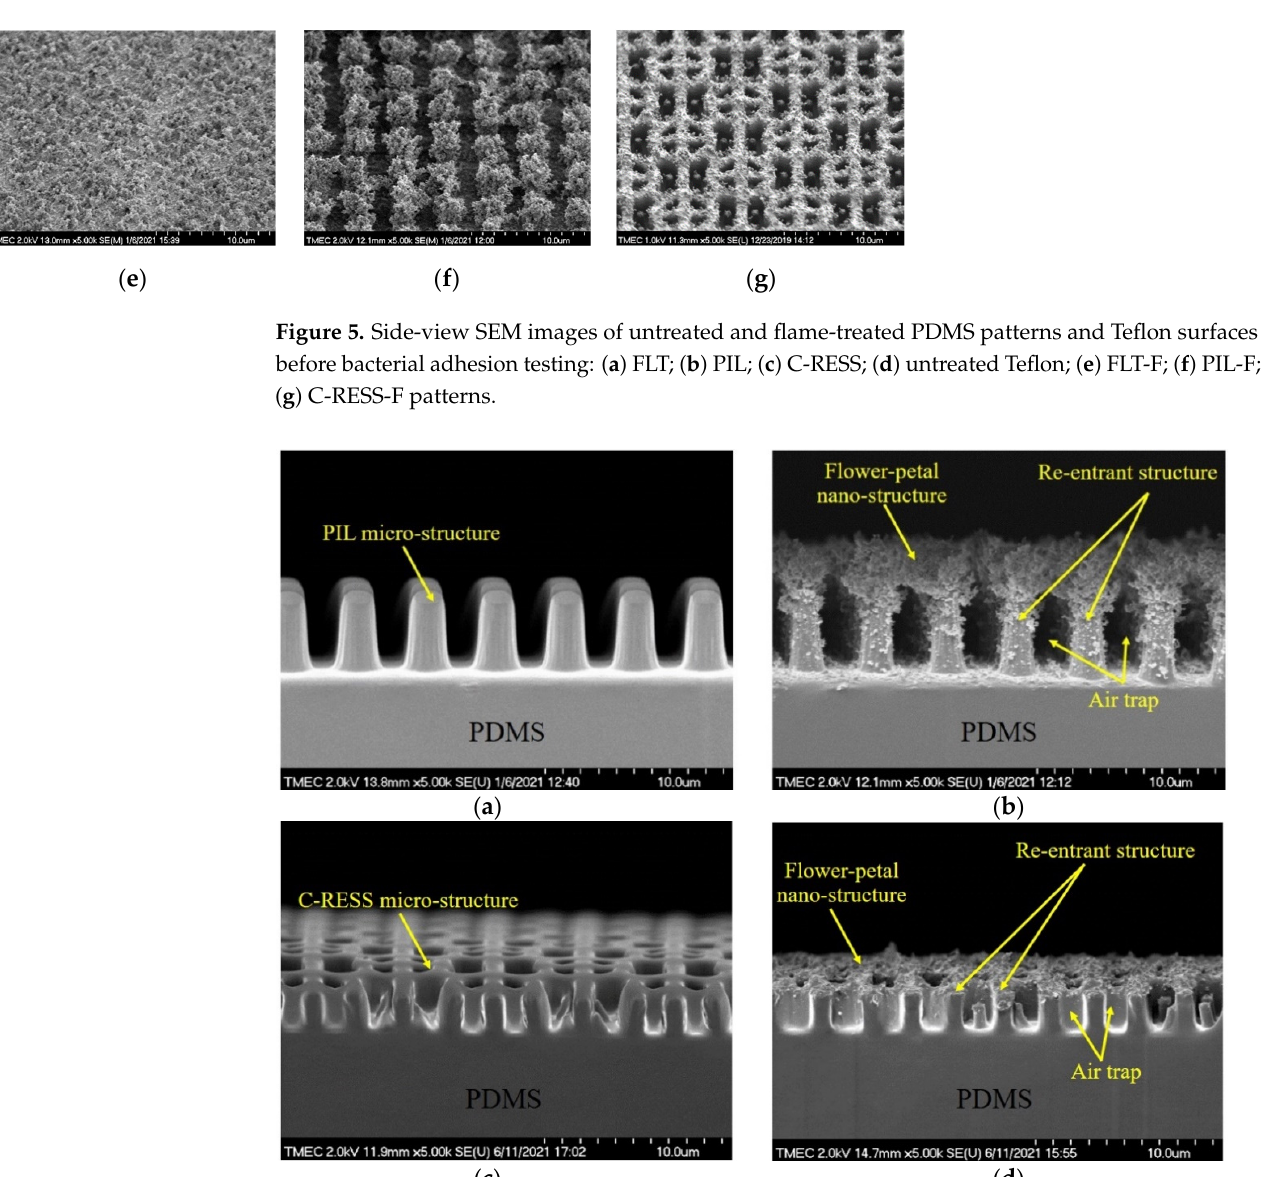
Figure 6. Cross − sectional SEM images of untreated and flame − treated PDMS patterns before bacte- Figure 6. Cross-sectional SEM images of untreated and flame-treated PDMS patterns before bacterial rial adhesion testing: ( a ) PIL; ( b ) PIL − F; ( c ) C − RESS; ( d ) C − RESS − F patterns. adhesion testing: ( a ) PIL; ( b ) PIL-F; ( c ) C-RESS; ( d ) C-RESS-F Both PIL and C − RESS patterns have smooth surfaces with nearly vertical sidewall profiles without sidewall scallop. The pattern heights (h) of PIL and C − RESS patterns were 4.62 ± 0.10 μ m and 2.55 ± 0.07 μ m, respectively. The variation in the Si etching rate on different densities of PIL and C − RESS micro − structures can be explained by the micro loading effect and the aspect ratio dependent etching (ARDE) effect [43,44]. Therefore, the average A.R.s of PIL and C − RESS micro − structures are approximately 2.47 and 5.10, re- spectively. After flame − treatment for 15 s, the pinch − off formation of flower petal nano − structures with a thickness of 3.14 μ m generated voids (air gaps) between the adja- cent PIL − F patterns by closing off the top surfaces. The flower petal nano − structures with the air gaps on the PIL − F pattern are similar to the re − entrant micro − structures [38]. In the case of the C − RESS − F pattern, the thickness of the flower petal nano − structures is around 1.0 μ m. Therefore, the pattern heights (h) of the PIL − F and C − RESS − F patterns after the flame treatment process for 15 s were increased to 7.76 ± 0.13 μ m and 3.55 ± 0.11 μ m, respectively. This led to increases in the A.R.s of PIL − F and C − RESS − F micro − structures to 4.14 and 7.10, respectively. The different growth rates of flower petal nano − structures on the PIL − F and C − RESS − F patterns might be due to the different surface areas that make contact with the flame. The AFM results in Figure 7 show that the RMS roughness values of FLT, PIL, C − RESS patterns, and Teflon surfaces were 34.6, 92.6, 344.0, and 77.2 nm, respectively. After flame − treatment for 15 s, the RMS roughness values of the FLT − F, PIL − F, and C − RESS − F patterns were 129.6, 210.5, and 424.0 nm, respectively. The combi- nation of the PIL micro − structure and flame treatment process can increase the RMS roughness of a flat PDMS surface from 34.6 to 210.5 nm.